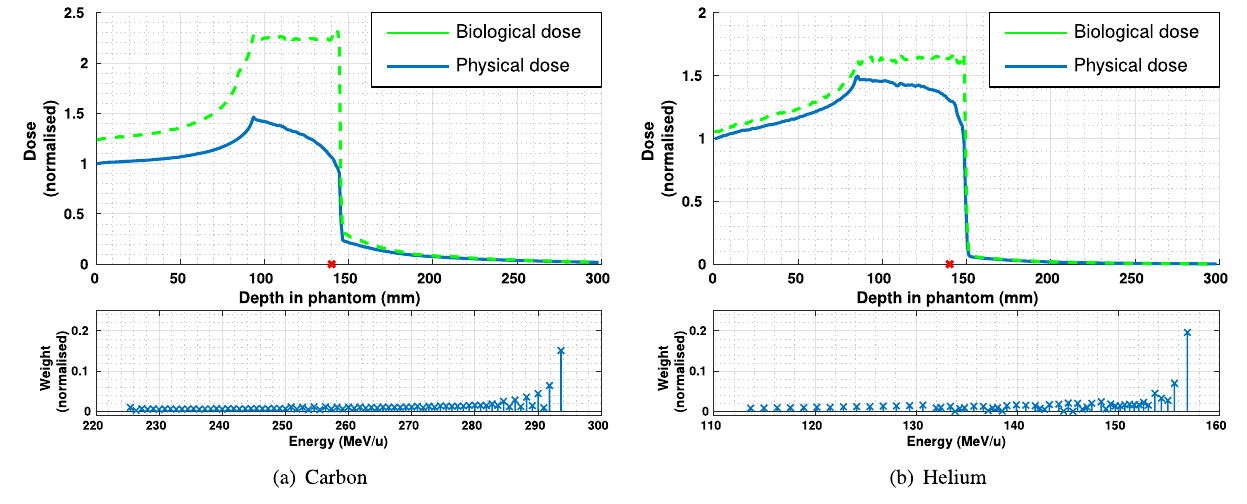
Figure 3. Depth-dose profiles (upper plot; blue = physical dose, green = biological dose) and energy spectra (lower plots) of polyenergetic carbon and helium ion beams; a red ‘X’ along the axis denotes the centroid of the NCI region.